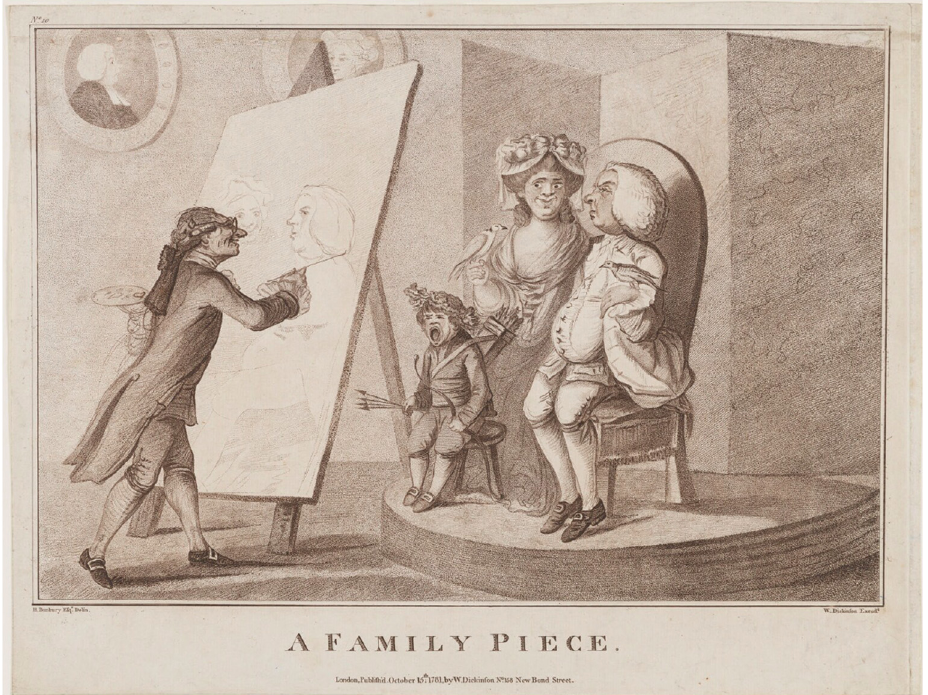
Figure 1. William Dickinson, after Henry William Bunbury, A Family Piece (1781), stipple engraving, © National Portrait Gallery, London, UK.